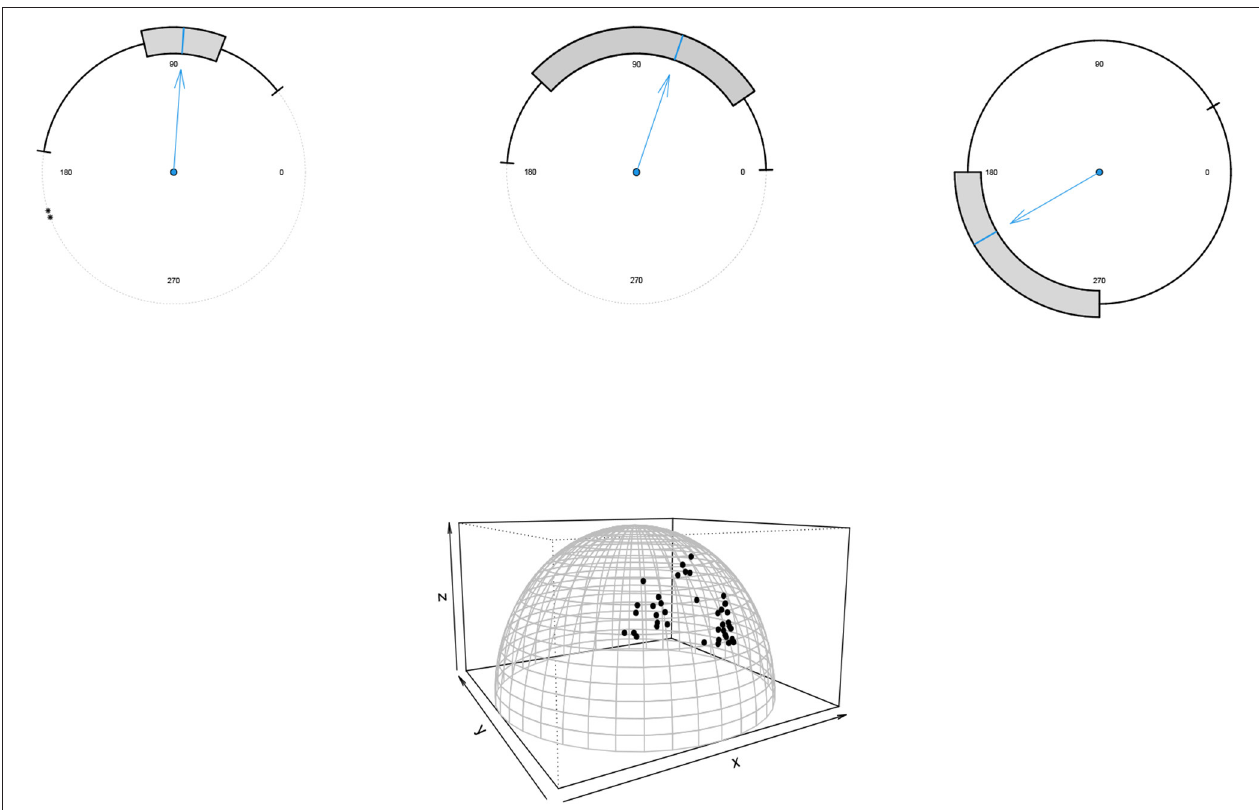
FIGURE 6 | (Top) the boxplots of the movement of blue periwinkles (left), long-axis orientations of feldspar laths (middle) and thunder at Kew (right) datasets. (Bottom) the scatter plot of the household expenditures dataset.